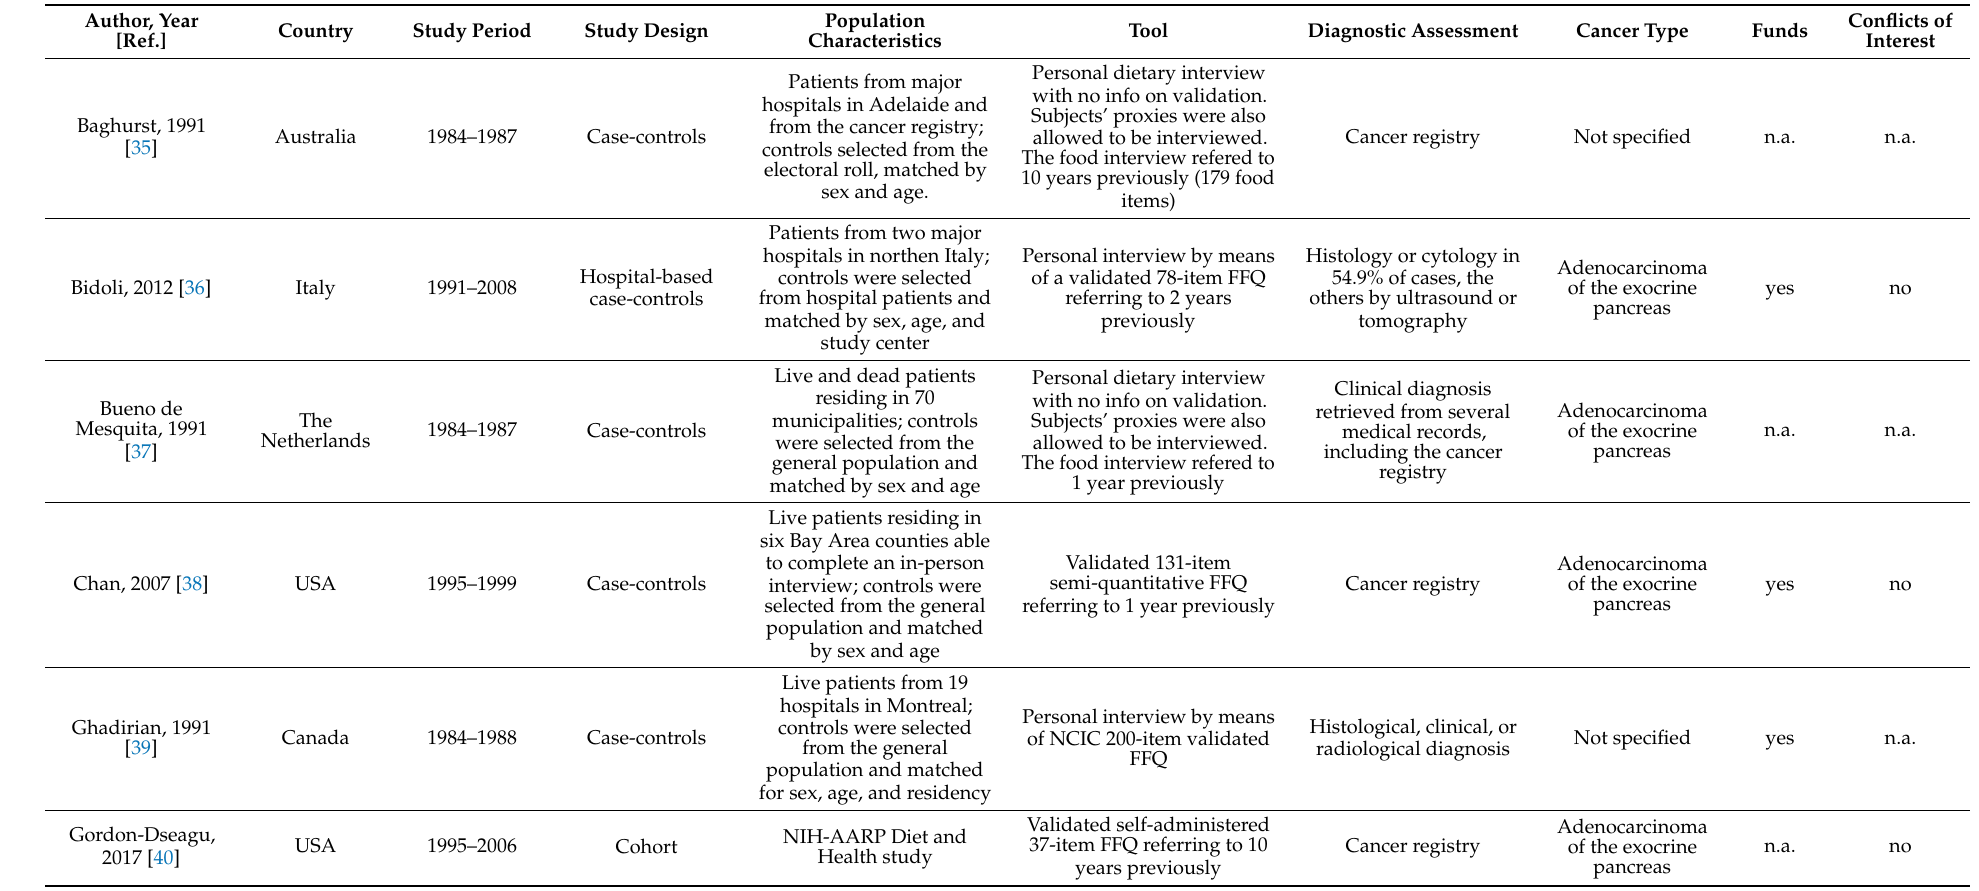
Table 1. Qualitative characteristics of included studies, reported in alphabetical